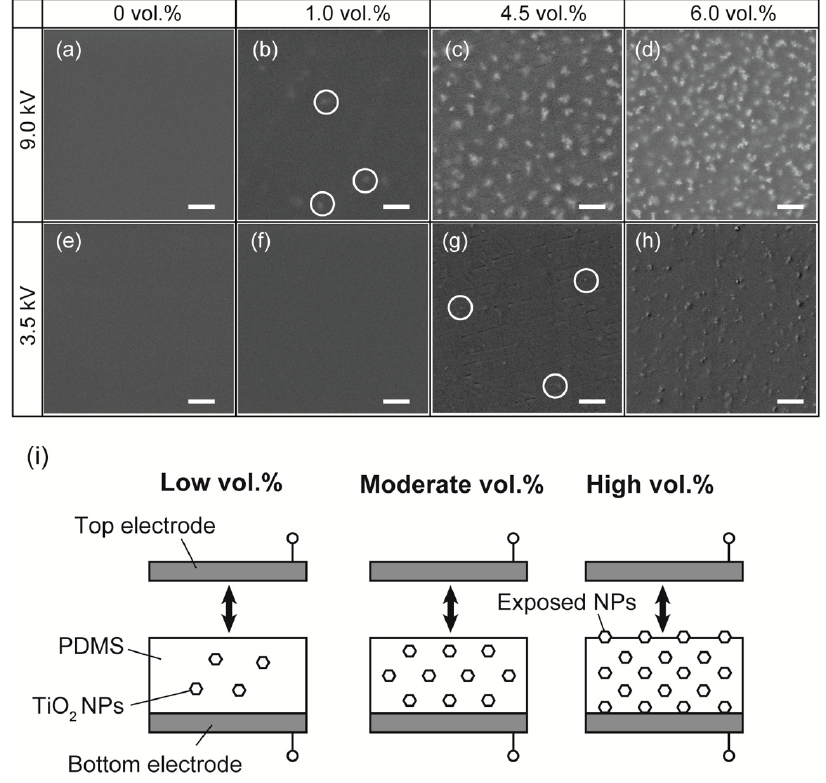
Figure 4. ( a – d ) SEM images of each content of TiO 2 NPs at acceleration voltages of 9 kV and ( e – h ) at acceleration voltages of 3.5 kV. The scale bars of the SEM images are 1 µ m. ( i ) The structure of the composite films with the different contents of TiO 2 NPs.